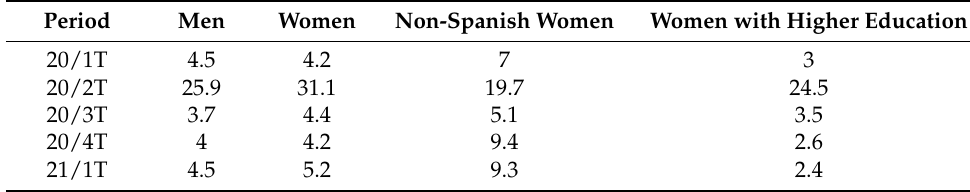
Table 3. Estimation of ERTEs, 2020–1st trimester of 2021.